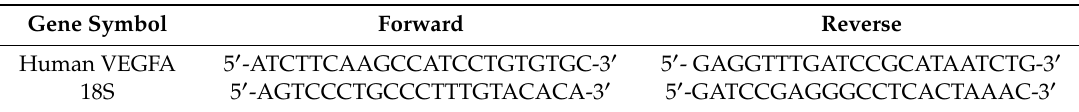
Table 3. Primer sequences for vascular endothelial growth factor A (VEGFA) and 18S ribosomal RNA (18S) genes. Gene Symbol Forward Reverse Human